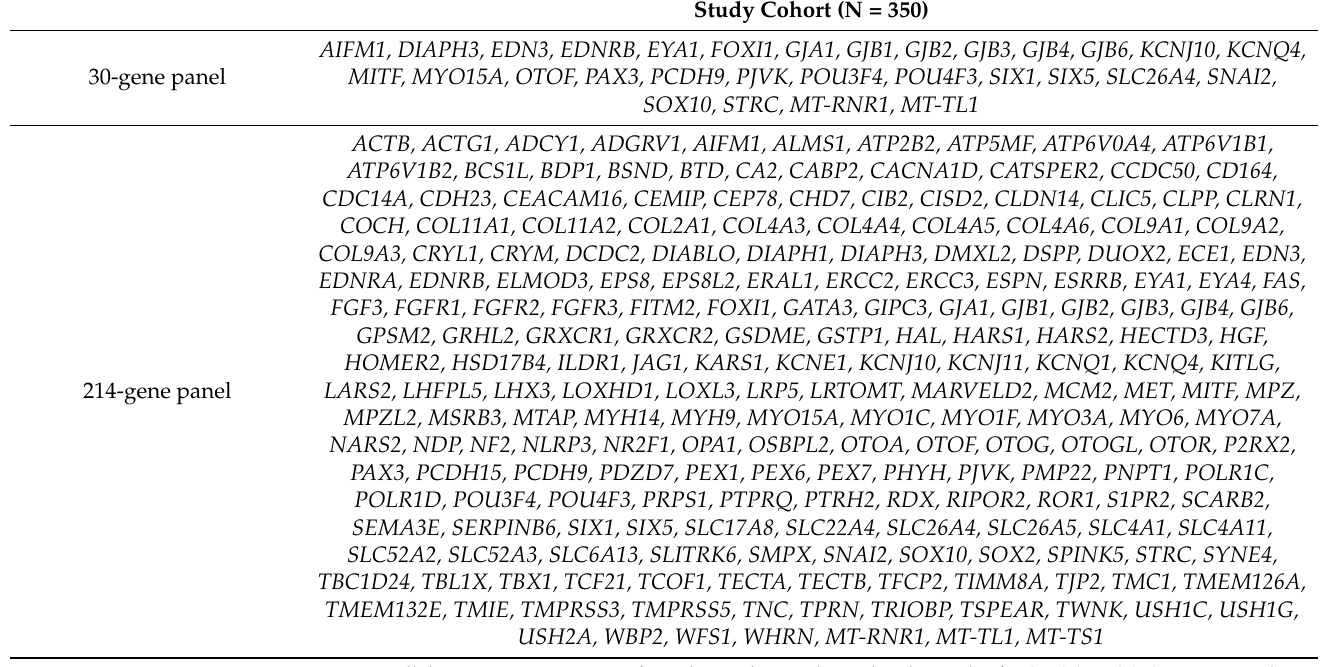
Table 1. Comparison of the 30-gene and 214-gene panels. Study Cohort (N =